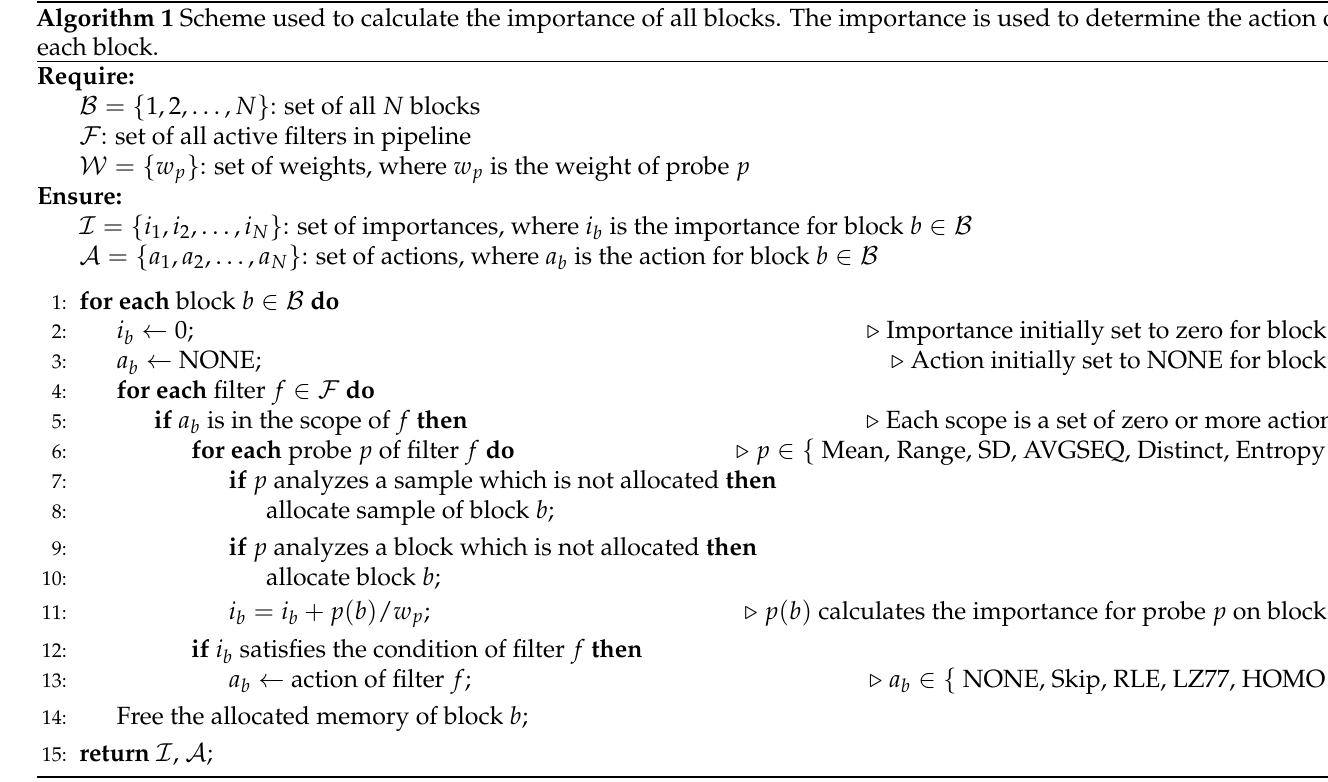
Algorithm 1 Scheme used to calculate the importance of all blocks. The importance is used to determine the action of each